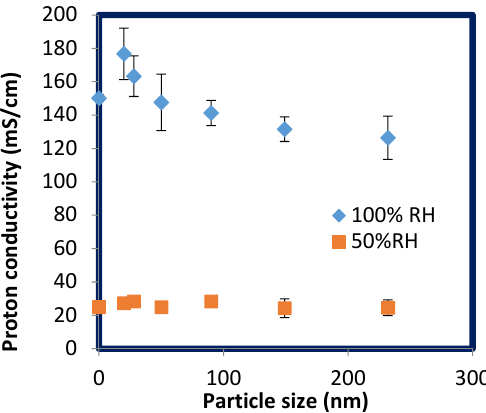
Figure 2. Proton conductivity of SPNSS nanocomposite membranes with recast Nafion at 80 °C. Proton conductivity increases with increase in relative humidity (RH) for all samples.